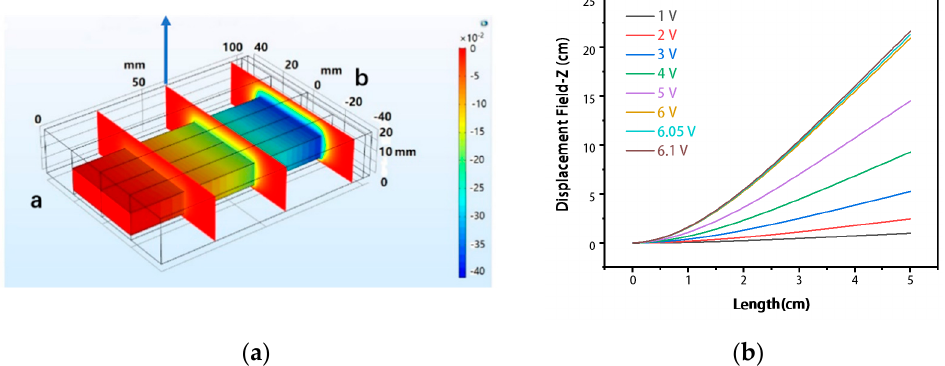
Figure 4. ( a ) Electric field distribution under different displacements. ( b ) Different positions, different displacement corresponding voltages.